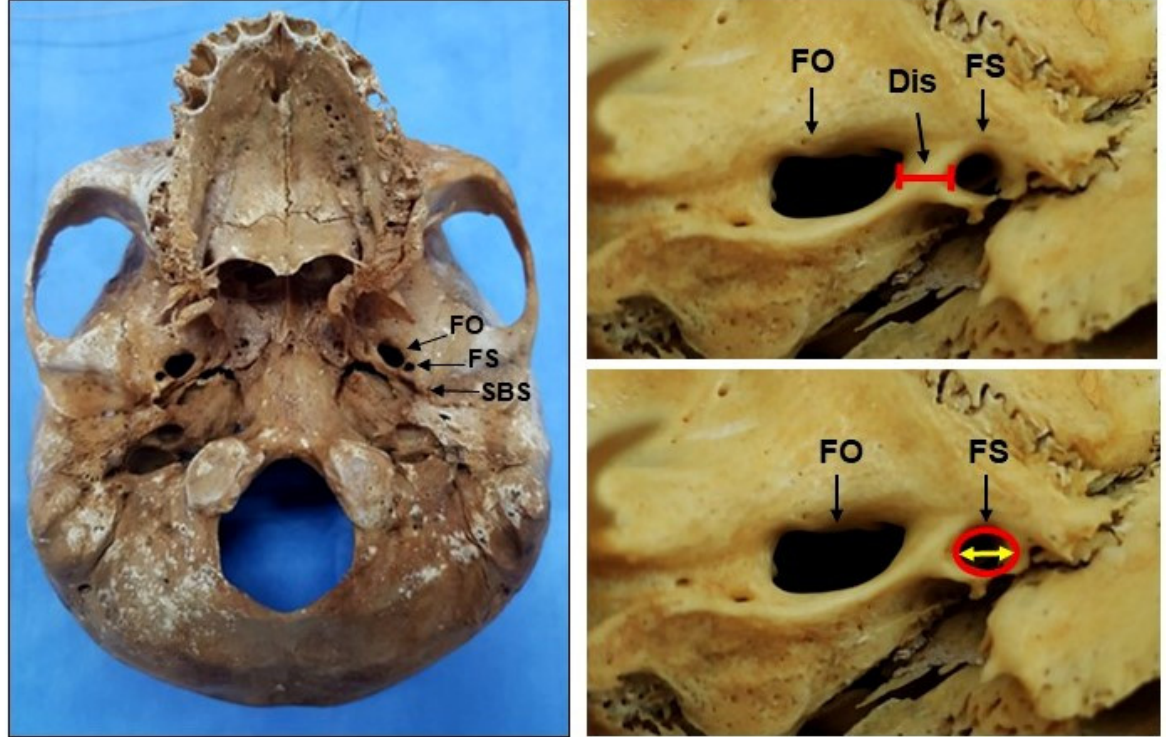
Figure 2. Inferior view of the skull showing the morphometric evaluation (red outline and yellow arrow) of the foramen spinosum (FS) and its distance (Dis) from the foramen ovale (FO) and spine of the sphenoid bone (SBS).